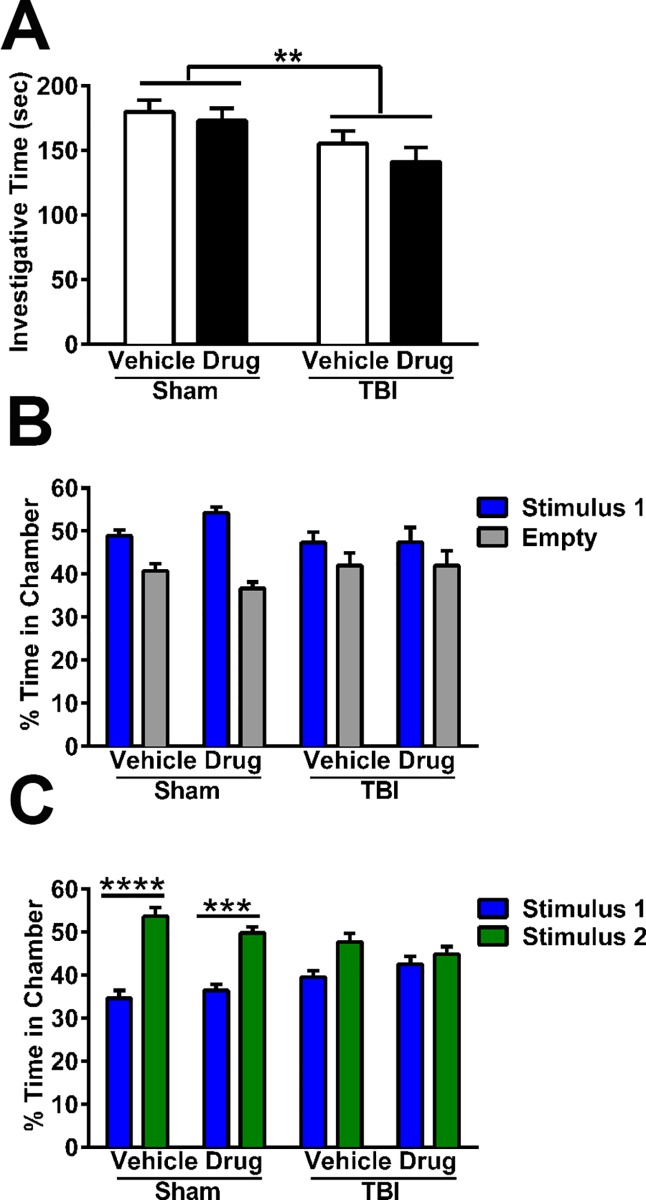
Acute gelatinase inhibitor does not attenuate deficits in social behavior at adulthood after pediatric TBI.(A) Social investigation was quantified by the resident-intruder paradigm, revealing that TBI mice as compared to sham controls spent less time investigating a naïve intruder mouse (2-way ANOVA overall effect of TBI, **p<0.01). (B) In the three-chamber social approach task (stage 2), all mice showed an overall preference for sociability with stimulus mouse 1 compared to the empty chamber (2-way RM ANOVA overall effect of chamber, p = 0.0003). (C) Stage 3 of the three-chamber task tested social novelty. Here, sham-operated mice revealed a preference for a novel stimulus mouse compared to the now-familiar mouse (2-way RM ANOVA interaction, p = 0.0055; subsequent Sidak’s post-hoc tests, ***p<0.001, ****p<0.0001 as indicated graphically). In contrast, TBI mice showed a lack of of social memory (n.s. by Sidak's post-hoc) (n = 15/group). Bars represent mean + sem.